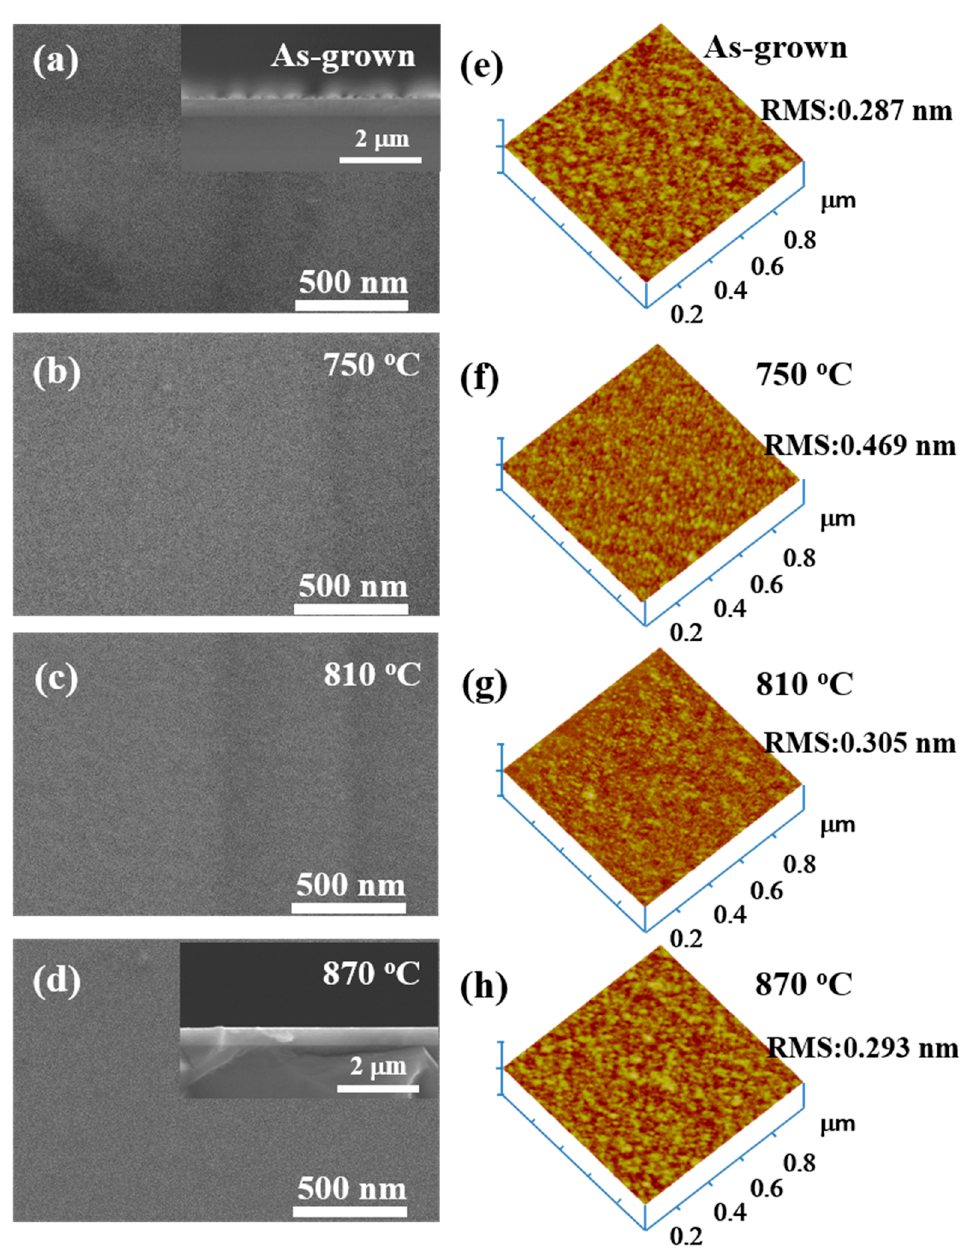
Figure 2. The cross-sectional and surface scanning electron microscopy (SEM) images ( a – d ) and atomic force microscopy (AFM) images of ZrB 2 films as grown and annealed at various temperatures ( e – h ): ( a , e ) as-grown, ( b , f ) 750 °C, ( c , g ) 810 °C and ( d , h ) 870 °C.